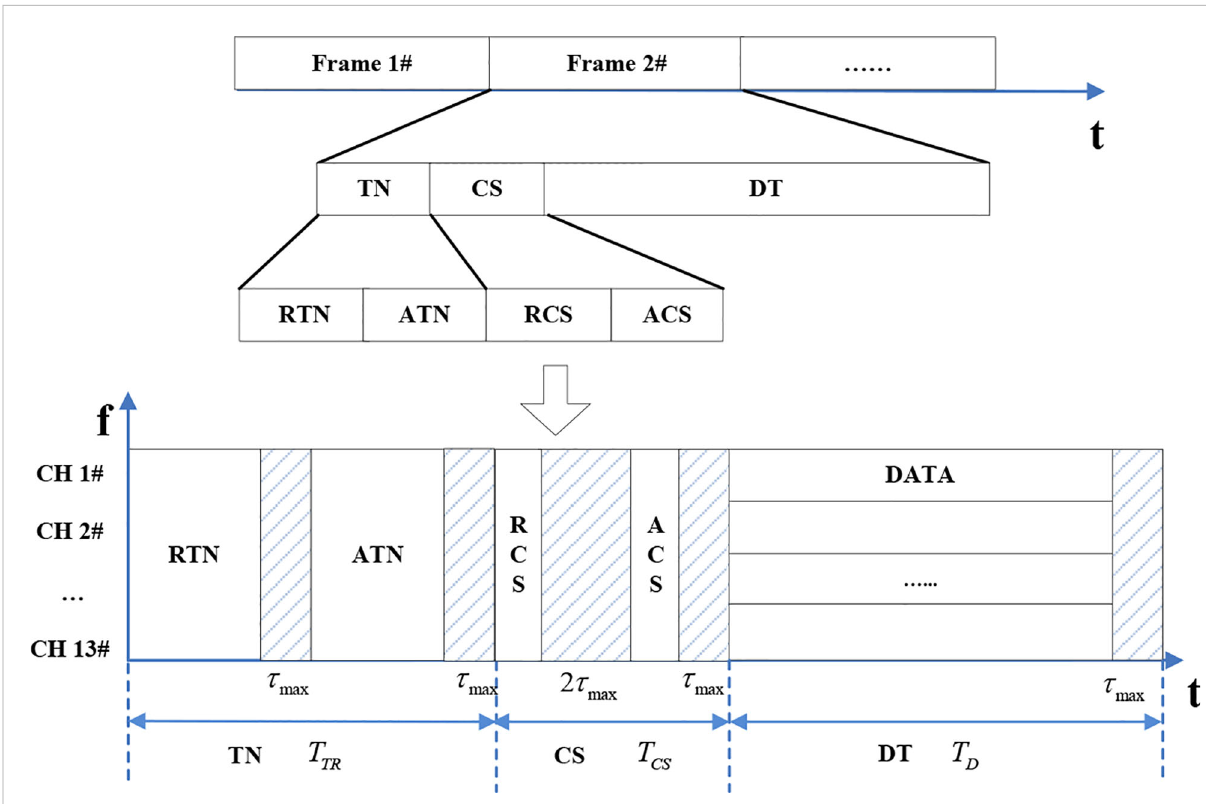
FIGURE 5 Synchronized work timing with frames being